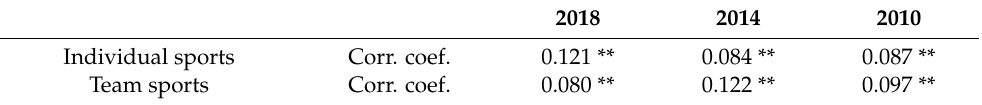
Table 2. Spearman correlation between FAS category (1–3) and sport participation